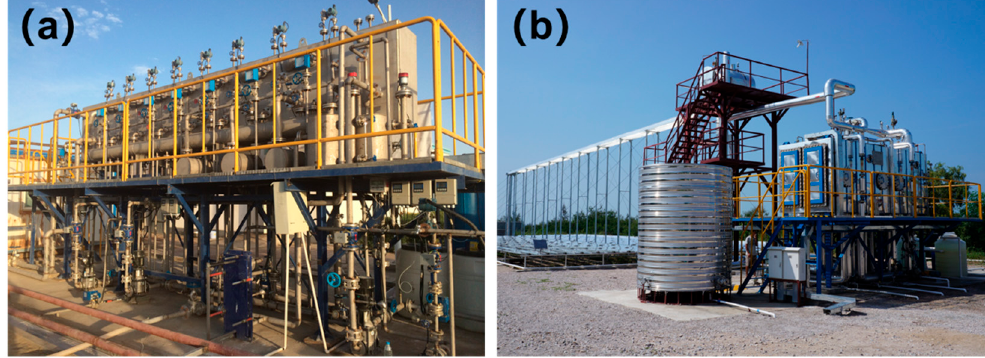
Figure 8. Solar energy driven desalination projects in China. ( a ) Solar-driven eight-effect plate distillation in Luntai, Xinjiang (MEP, 24 m 3 /d). ( b ) Solar-driven low temperature MED in Ledong, Hainan (30 m 3 /d).